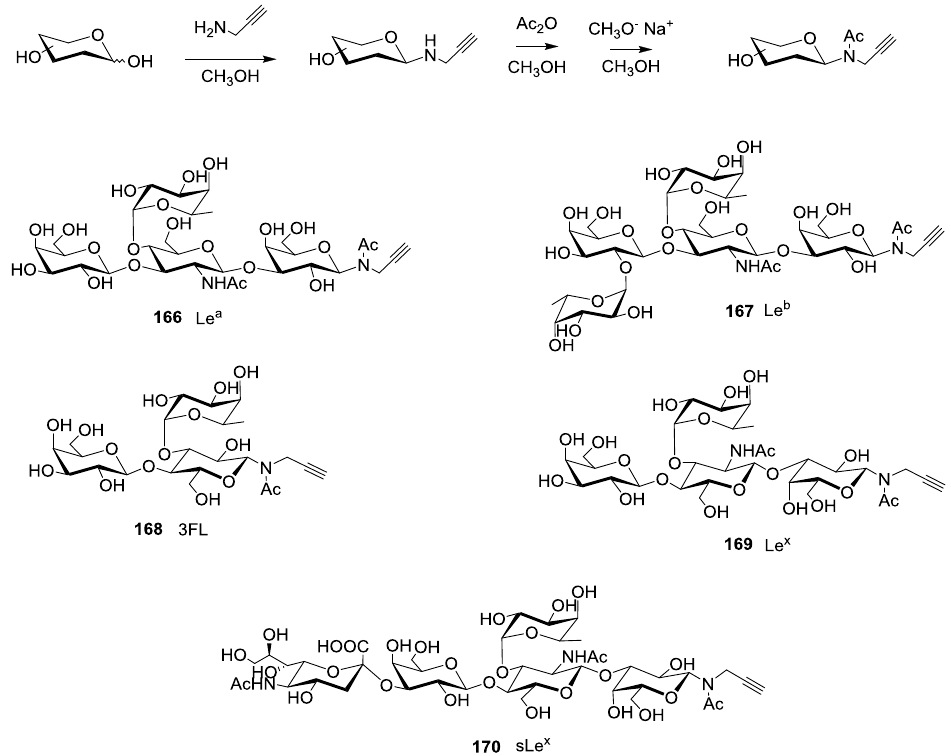
Figure 5. Structure of azide solid support 157 N 3 -propargyl furanoside uracyl 158 – 160 and propargyl pyranoside 161 – 163